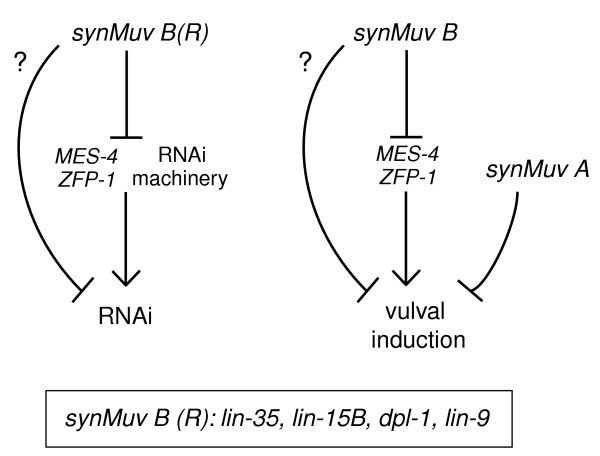
A comparison of the genetic pathways that regulate RNAi and vulval development. A subset of the synthetic Multivulva B genes, designated the synMuv B(R) genes, negatively regulate vulval induction (redundantly with the synMuv A pathway), and also negatively regulate somatic and germline RNAi. In both processes the genes mes-4 and zfp-1 act genetically downstream of, or in parallel to, the synMuv B(R) genes. The identities of the synMuv B(R) genes are given below the figure.